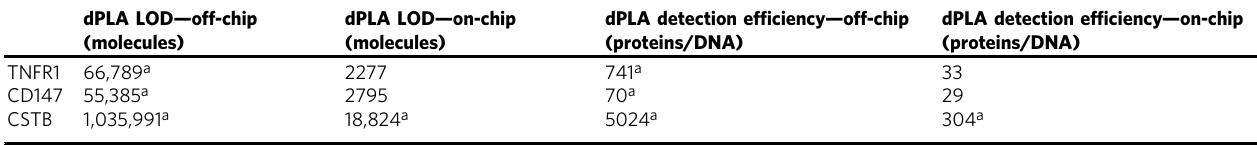
Table 1 Comparison of regular (off-chip) and micro fl uidic (on-chip) dPLA performance dPLA LOD — off-chip dPLA LOD — on-chip (molecules)